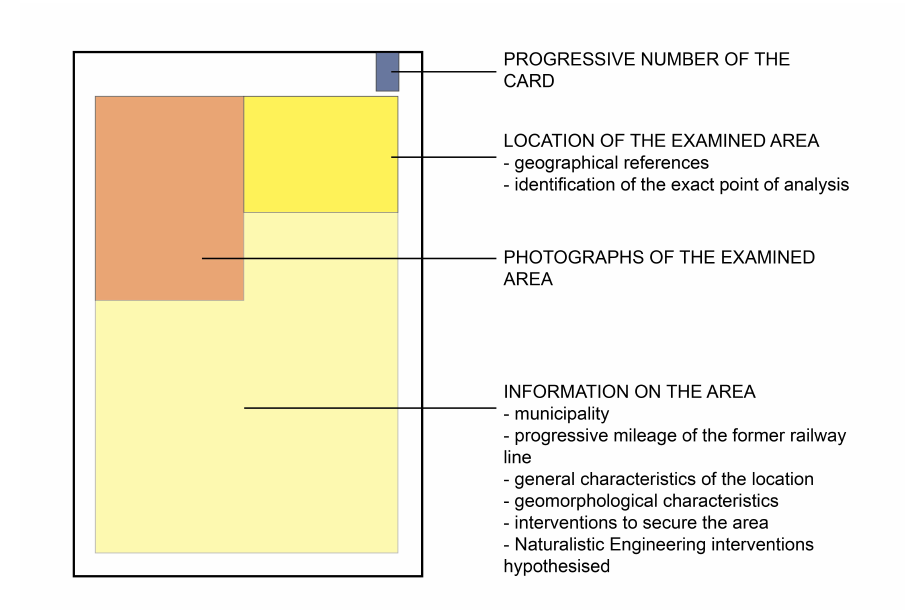
Figure 4. Example of sheet with synthetic information on studied